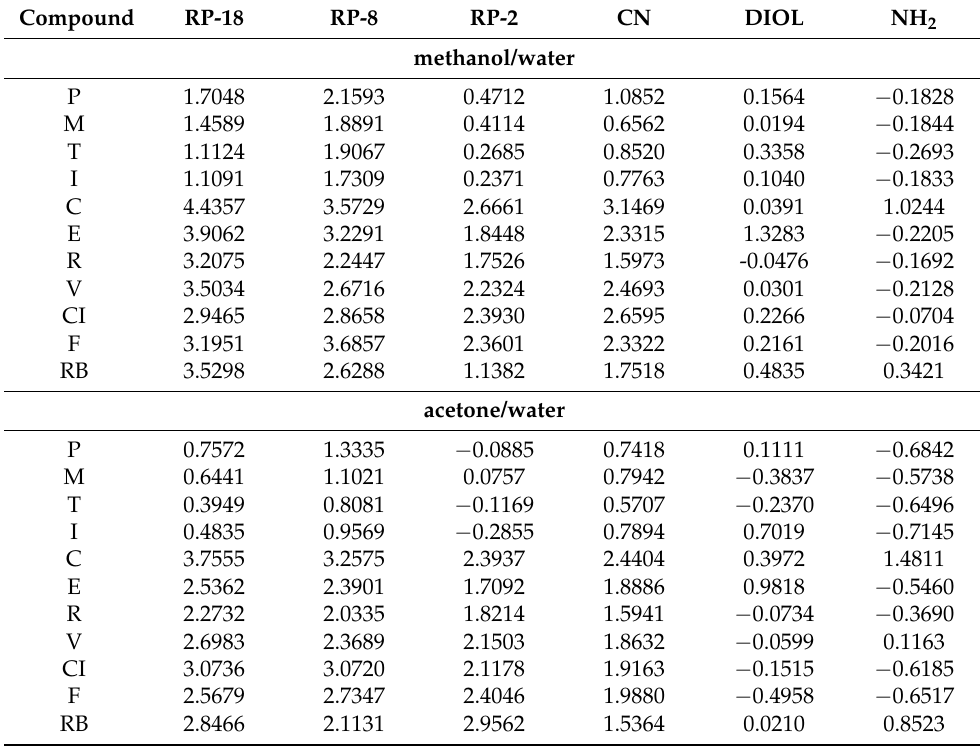
Table 1. Comparison of the value of the R M0 parameter for the investigated drugs with the use of different stationary phases in the methanol/water and acetone/water